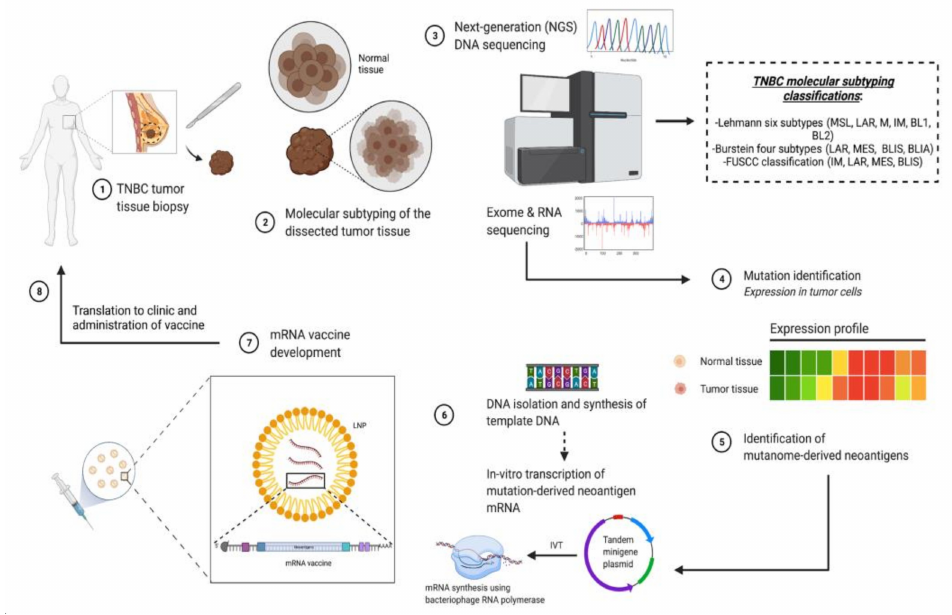
Figure 3. Development of personalized mRNA vaccines for